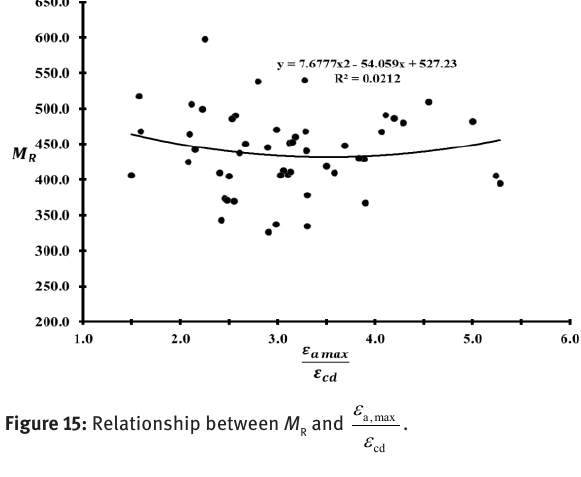
Fig. 19. Relationship between M and R 𝜎𝜎 𝑐𝑐𝑐𝑐